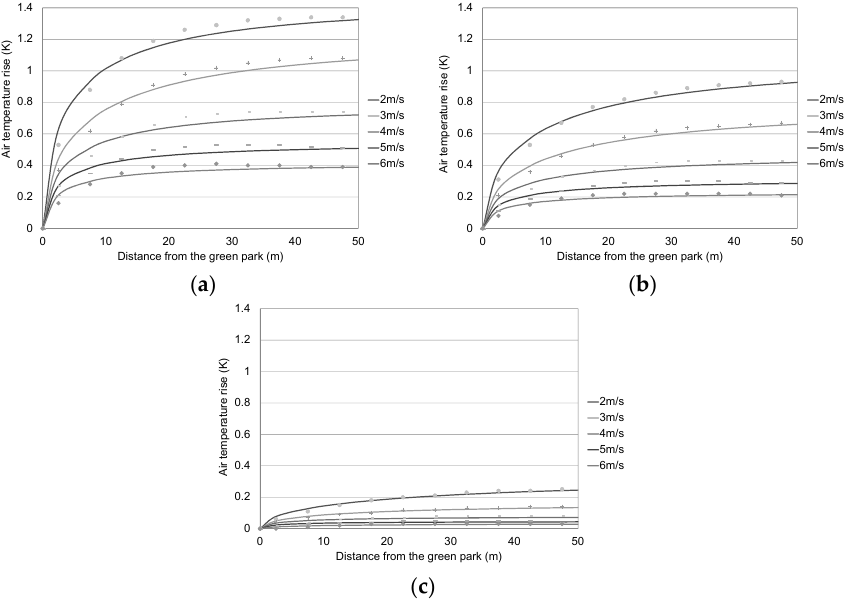
Figure 14. Air temperature rise by Equation (15). In the cases where the sensible heat flux is ( a ) 236.7 W/m 2 ; ( b ) 132.5 W/m 2 ; ( c ) 28.3 W/m 2 . Table 3. Coefficient a when it is approximated by Equation (14).